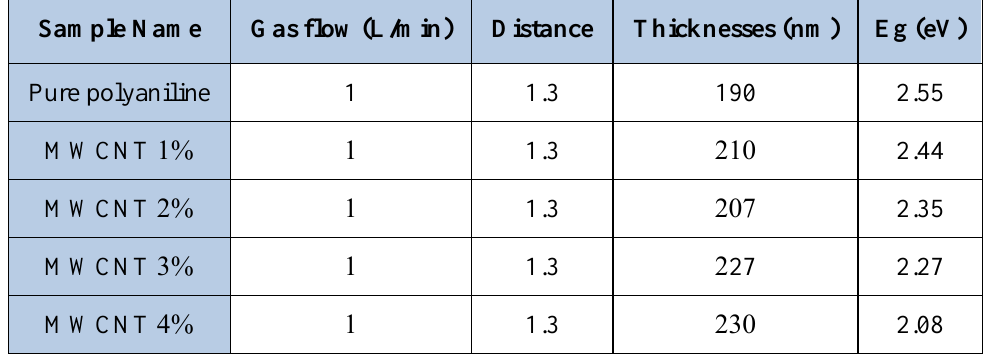
Table 2: The experimental condition for the preparation of Pure PANI and PANI/MWCNTs nanocomposites thin film by plasma